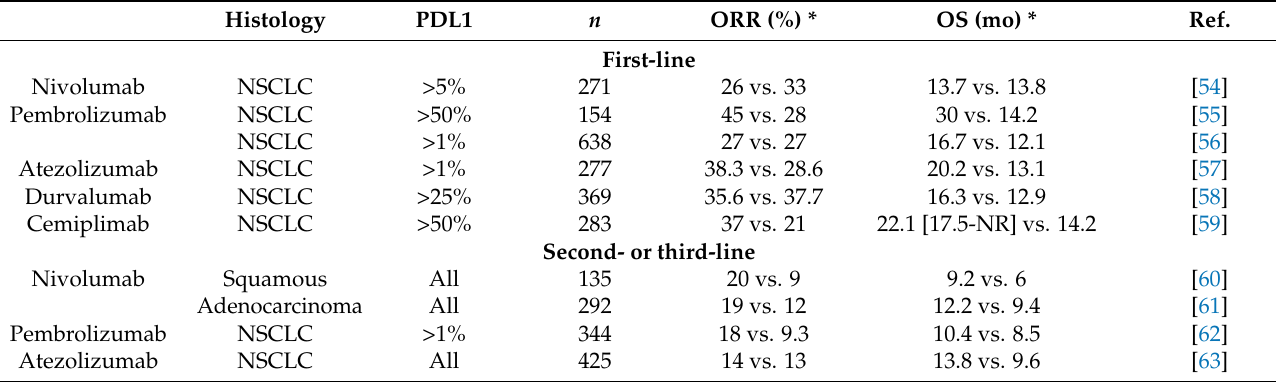
Table 2. Results of the main trials evaluating anti-PD1/PD-L1 monotherapy in stage IV